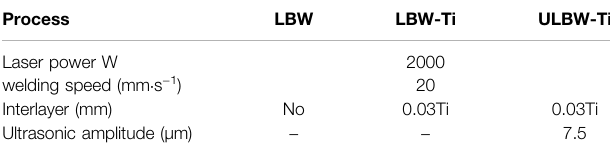
TABLE 1 | Main parameters of laser welding